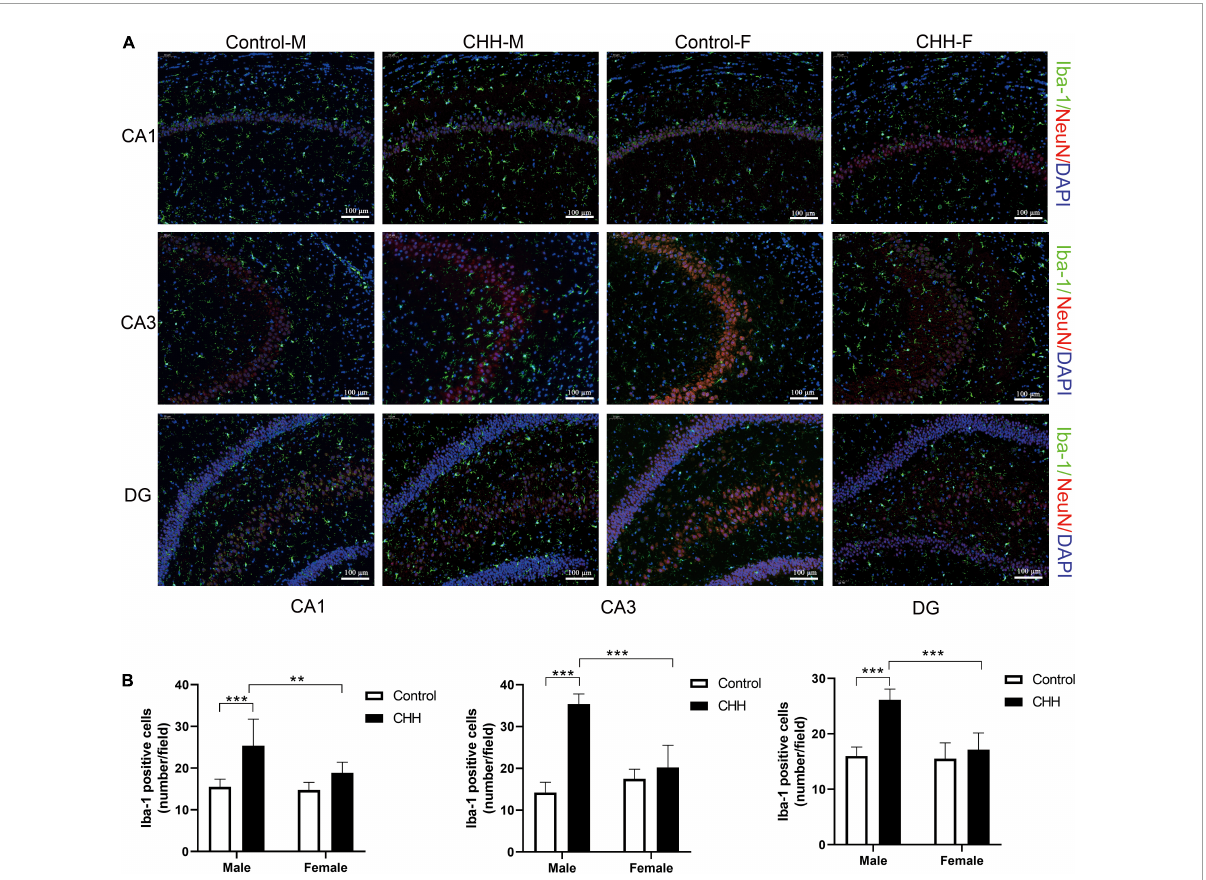
FIGURE6 The effects of CHH exposure on the number of microglia. (A) Representative images of Iba-1 immunofluorescence staining in the hippocampal CA1, CA3, and DG regions, scale bar: 100 µ m. (B) The statistical analysis of Iba-1 positive cells in the hippocampal CA1, CA3, and DG regions is shown. Values are means ± SD for six animals/group. Data for male and female rats, with or without CHH exposure, were analyzed using two-way ANOVA. Post hoc analysis indicated: * p < 0.05, ** p < 0.01, *** p <